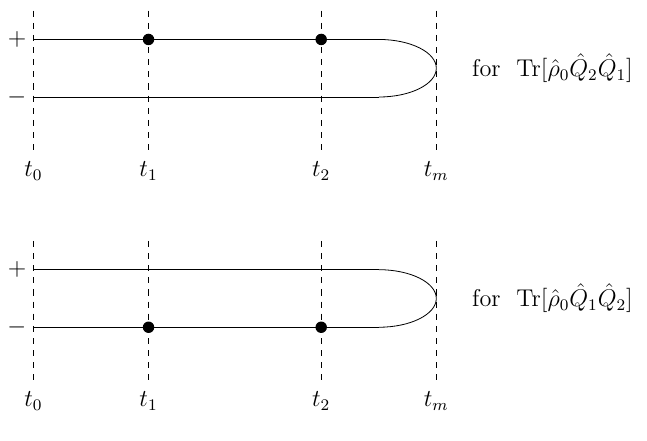
Figure 1 . A plot showing the placement of operators on the closed-time contour for the terms needed in the anticommutator, with t